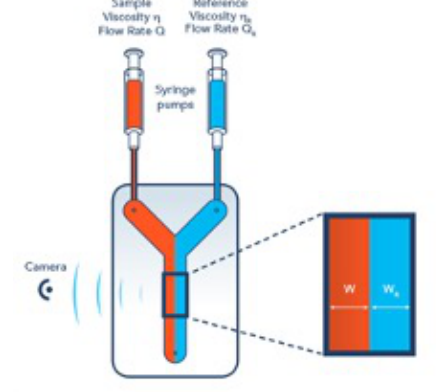
Figure 1: Schematic representation of the laminar co-flow of two fluids inside the FLUIDICAM RHEO TM microfluidic